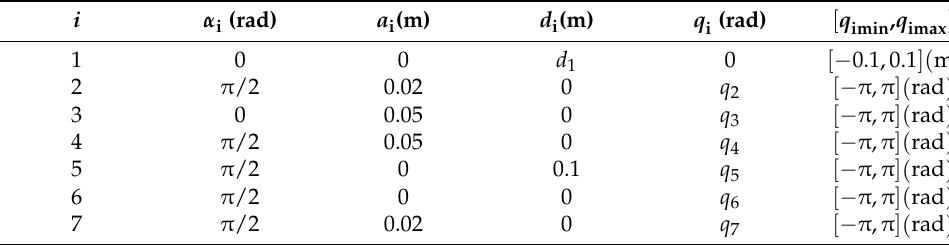
Table 2. Modified DH parameters of the 7-DOF serial